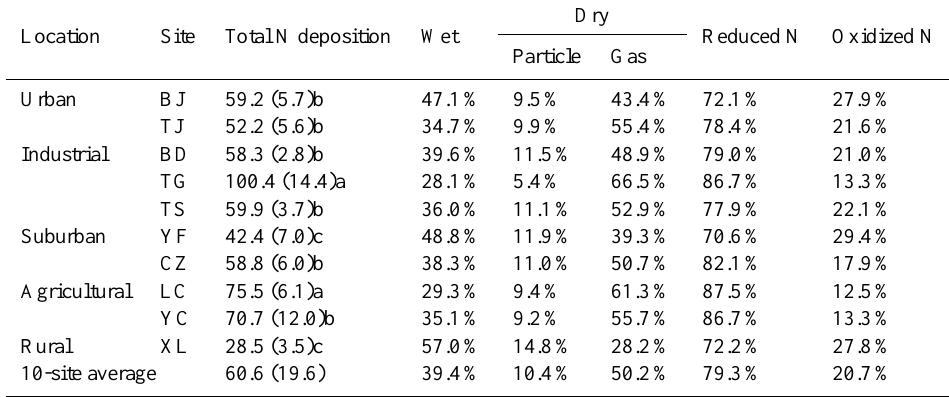
Table 2. Contribution of different pathways and species to the estimated total N deposition (kgNha − 1 yr − 1 ) in Northern China.